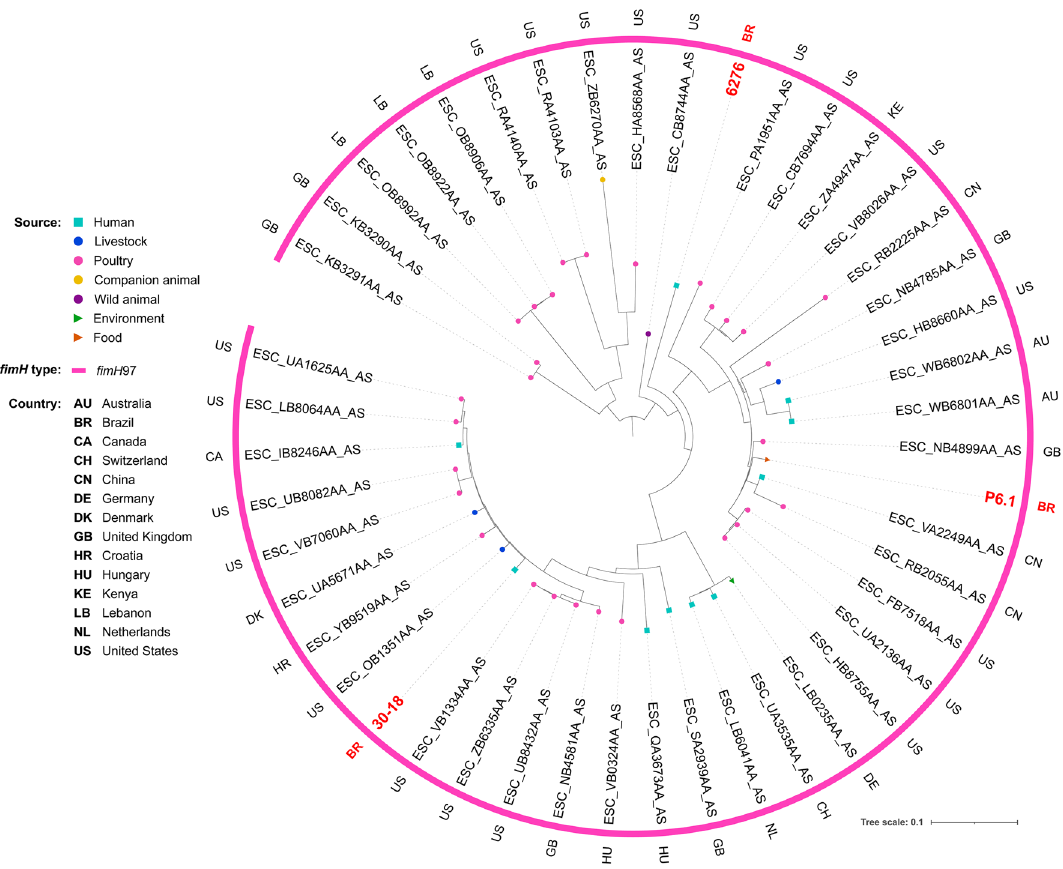
Figure 3. Phylogenetic tree of 46 Escherichia coli ST117 strains, their source, country of collection and fimH